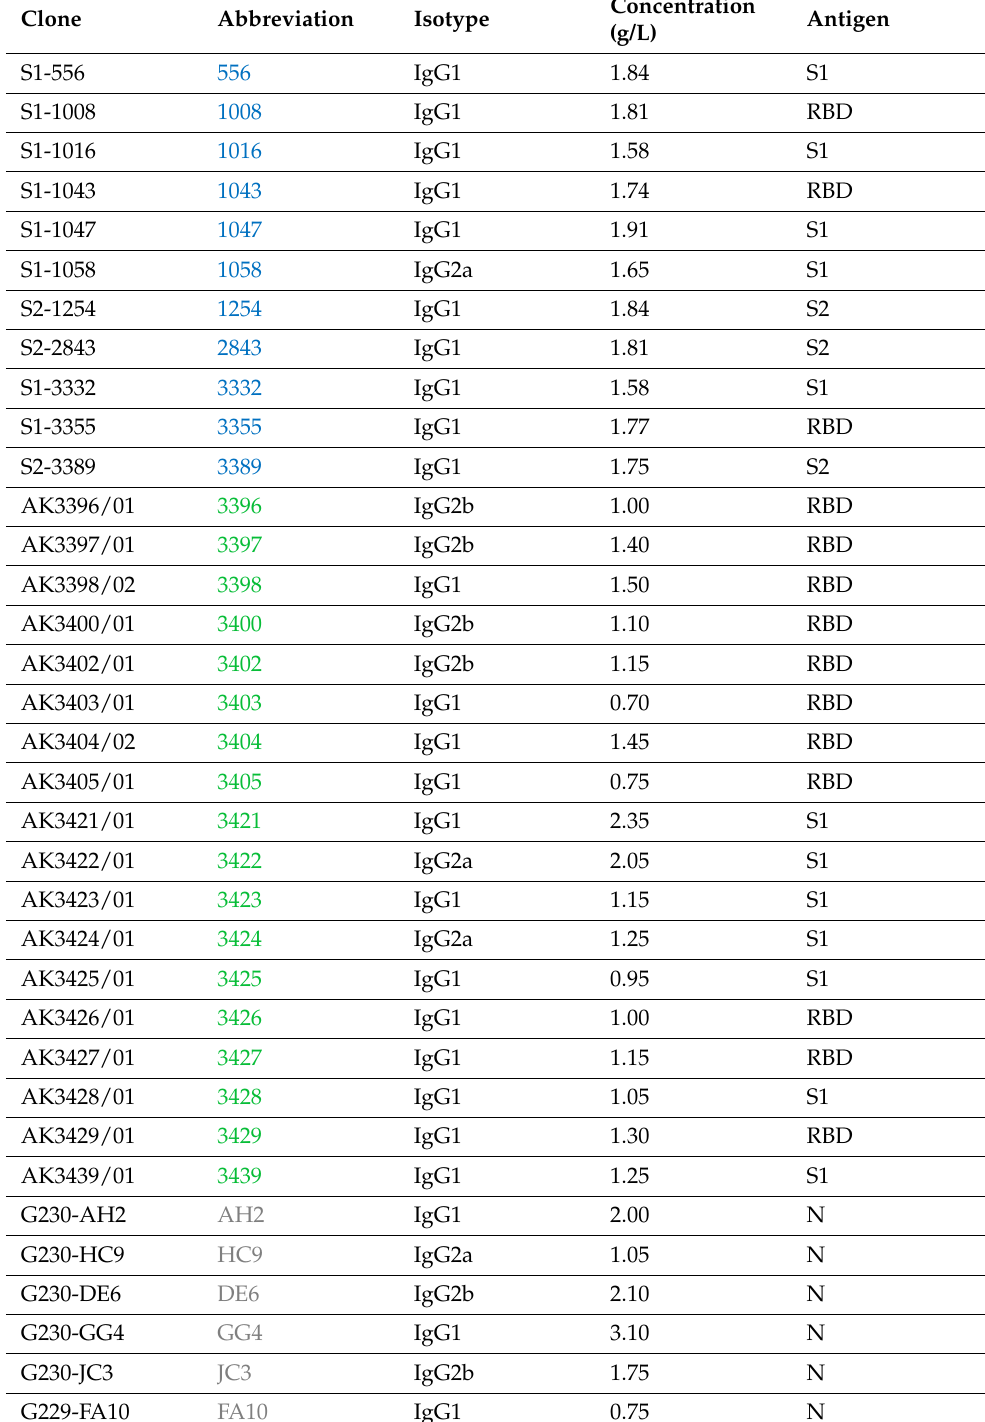
Table 1. Murine SARS-CoV-2 antibodies used in this